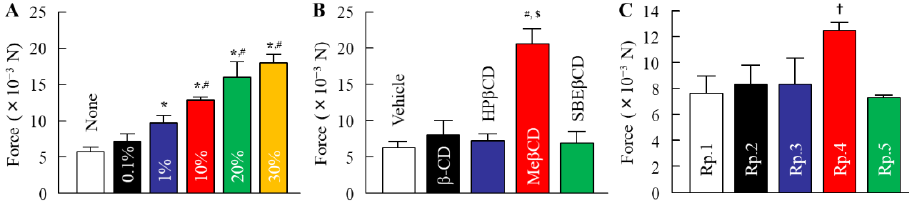
Figure 1. Effect of each CD on the tensile stress (stickiness) in the DEET/EtOH/CD formulations. ( A ) Changes in tensile stress of the 0.1–30% HP β CD solution. ( B ) Changes in tensile stress of the various 0.1% CD solutions. ( C ) Changes in tensile stress of the DEET/EtOH/CD (10:40:0.1%) formulations (Rp. 1 – 5 formulations). The compositions of DEET/EtOH/CD formulations (Rp. 1 – 5 formulations) are shown in Table 1. n = 5 – 8. * p < 0.05 vs. None for each category. # p < 0.05 vs. 0.1% HP β CD for each category. $ p < 0.05 vs. Vehicle for each category. † p < 0.05 vs. Rp. 1